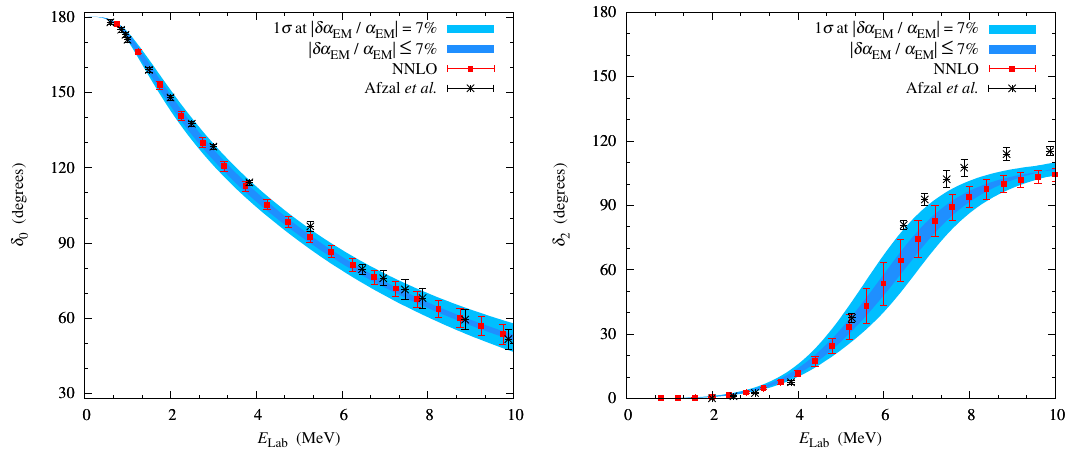
Figure 8 . Dependence of the α - α phase shifts on the fine-structure constant at NNLO. Left panel: S-wave phase shift δ versus the energy in the laboratory system, E . Right panel: D-wave phase 0 lab shift δ versus the energy in the laboratory system, E . The black crosses refer to the experimental 0 lab data, the red squares are the results for δα = 0 , the dark blue band corresponds to variations EM in α 7%(5%) , for the S-(D-)wave and the light blue band represents the corresponding EM /α EM ≤ 1 σ